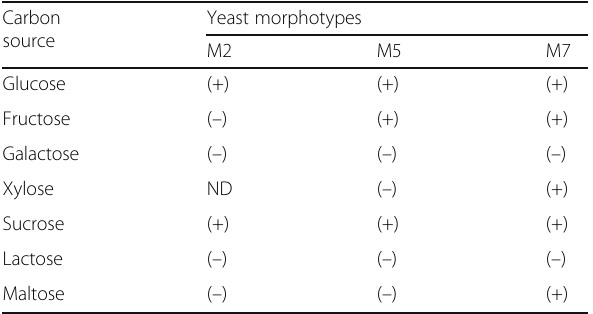
Table 1 Fermentation profile using different carbon sources of the yeast morphotypes: M2, M5 and M7, based on the methyl red method (Sanclemente 2015). Positive fermentation is indicated with (+). Absence of fermentation is indicated with ( – ) Carbon source